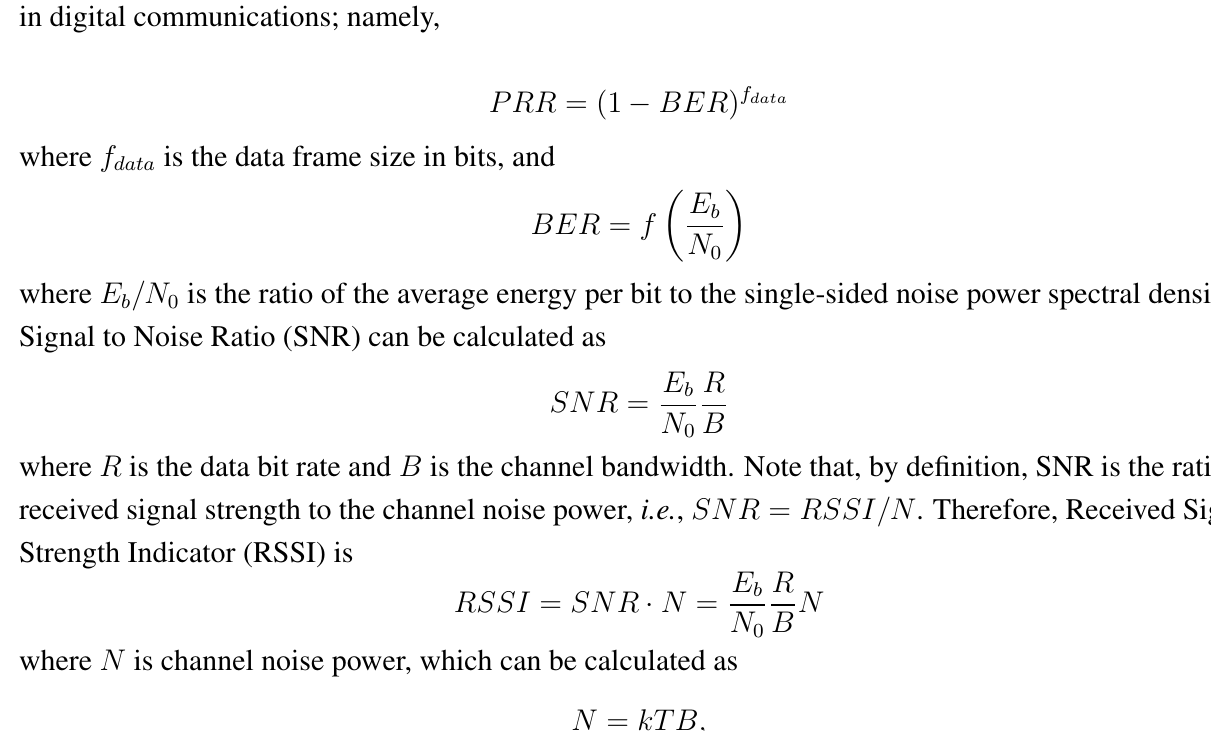
Table 1. Wireless link quality, e.g., PRR, is a function of Bit Error Rate (BER) and the packet